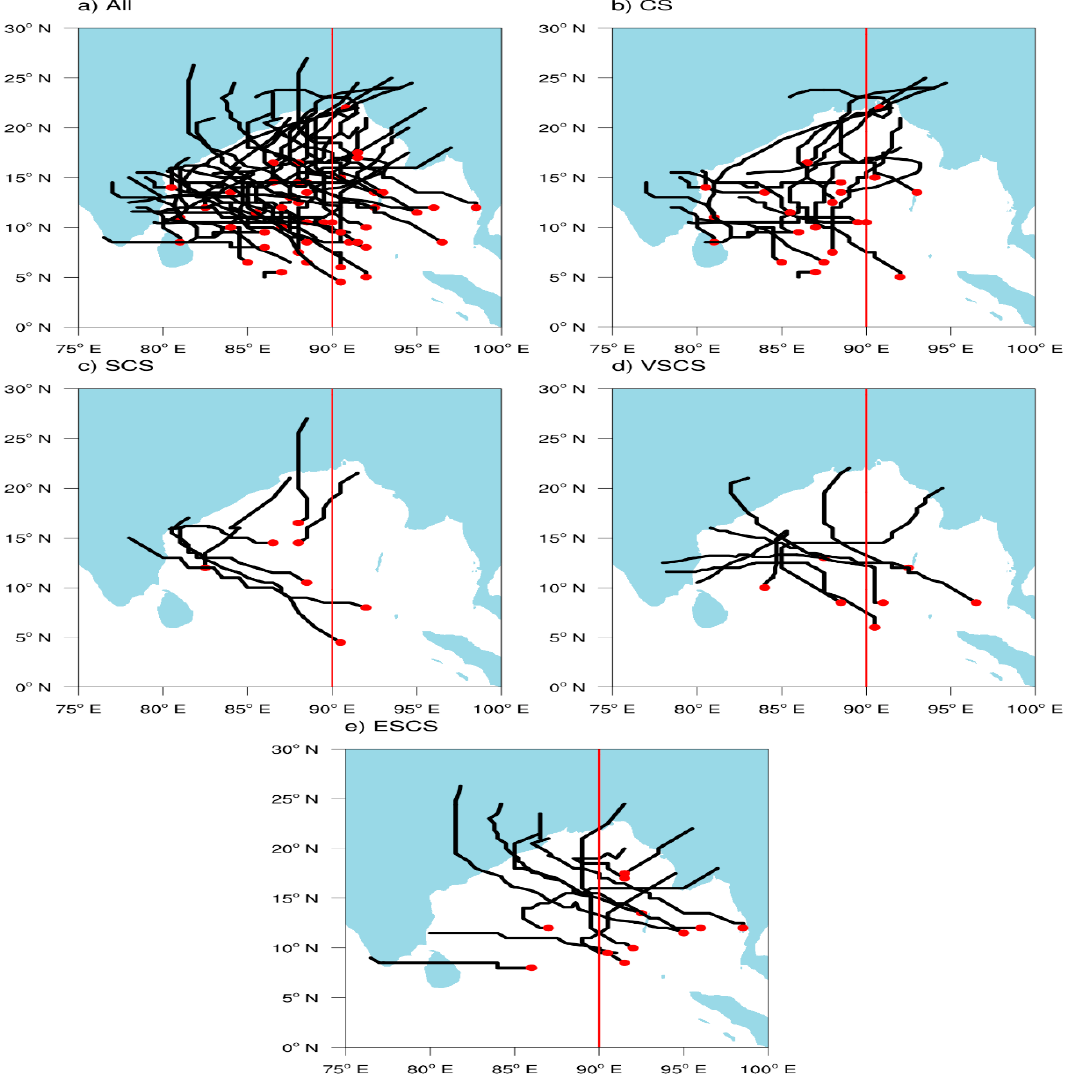
Figure 2. Tracks for ( a ) all TCs, ( b ) CSs, ( c ) SCSs, ( d ) VSCSs, and ( e ) ESCSs in BoB from 1998 to 2016. The red dots indicate the genesis point while the red lines denote the dividing line of BoB.